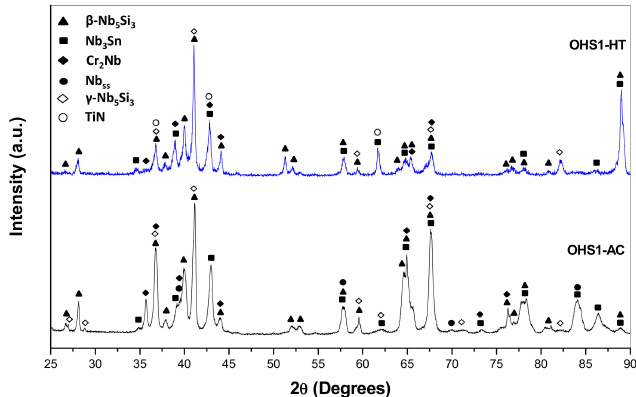
Figure 2. X-ray di ff ractograms (XRD) of the alloy OHS1 in the as-cast (AC) and heat-treated (HT) conditions. The XRD data agreed with the data from the following JCPDS (International Center for Di ff raction Data) cards: (34-370) for Nb ss , (30-0875) for β Nb 5 Si 3 , (65-4327) for Ti-rich Nbi 5 Si 3 , (19-875) for the Nb 3 Sn, (47-1637) for the NbCr 2 Laves phase, and (38-1420) for the